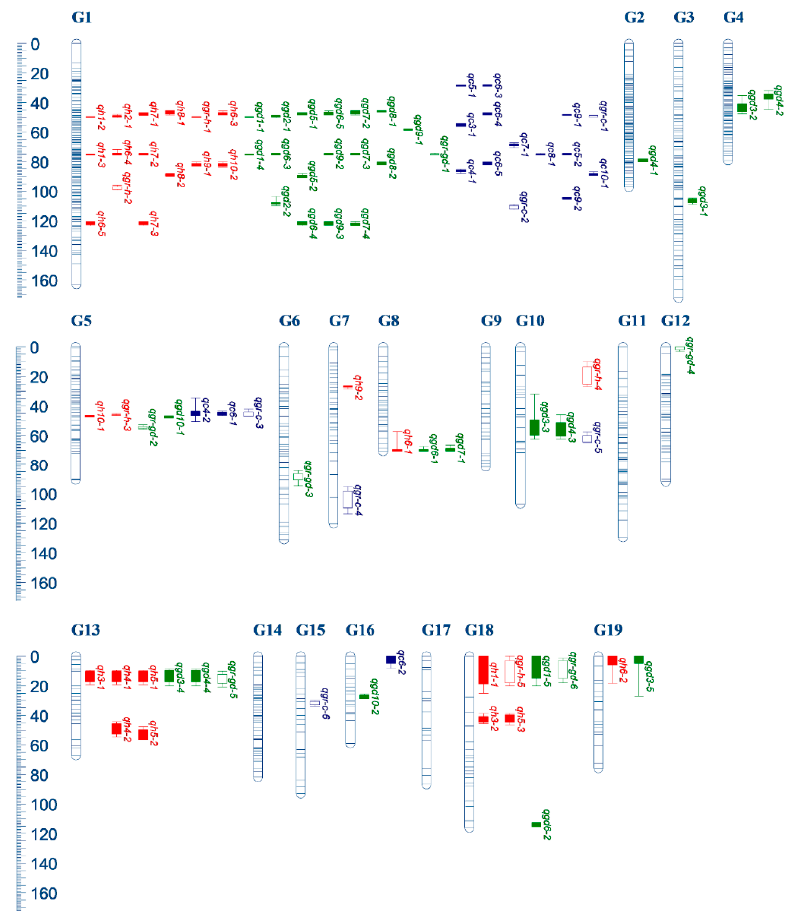
Figure 3. QTL mapping on genetic linkage groups for growth traits in Eucommia ulmoides . Red, green and blue bars represent QTLs for height, ground diameter and crown diameter, respectively. The hollow bars represents QTLs for growth rates. Thick bars and thin lines represent 1 ‐ LOD and 2 ‐ LOD confidence intervals of each QTL, respectively. QTLs name were described in Table 3.